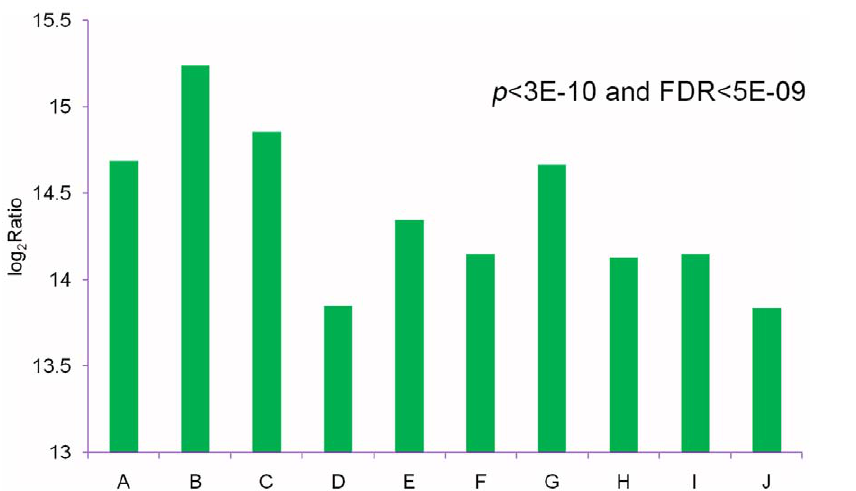
Figure 5. Analysis of expression levels of the top ten up-regulated transcripts between the two samples (RS vs. SS). The y -axis indicate the fold-changes of up-regulated genes. Categories in the x -axis represent genes homologous to (A) ‘heme/copper-type cytochrome/quinol oxidases, subunit 1’, (B) ‘F 0 F 1 -type ATP synthase, subunit a’, (C) ‘heme/copper-type cytochrome/quinol oxidases, subunit 2’, (D) ‘cytochrome b subunit of the bc complex’, (F) ‘heme/copper-type cytochrome/quinol oxidase, subunit 3’ and (J) ‘NADH: ubiquinone oxidoreductase subunit 1 (chain H)’,respectively. The remaining genes (E, G, H, I) had no functional annotation.